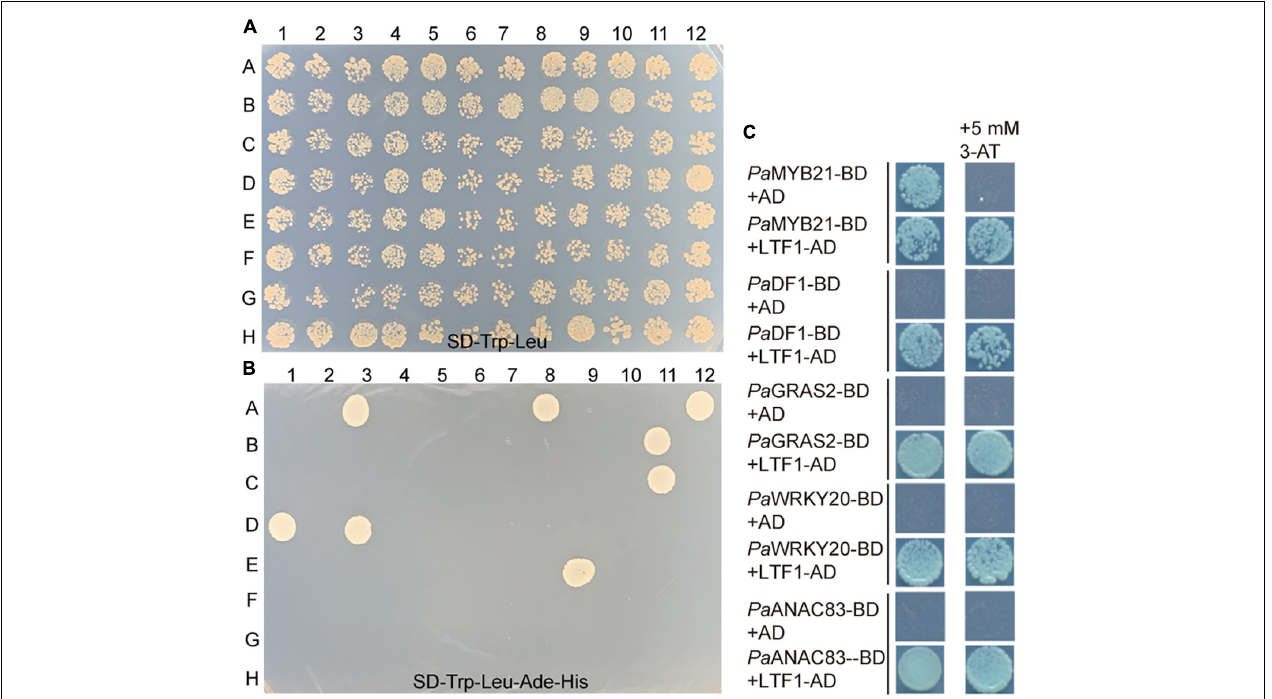
FIGURE 3 | Identification of TFs that interact with Pa MYB4/LTF1. (A,B) Y2H screening of this TFs library by mating the bait Pa MYB4/LTF1. Strong interaction can be detected on the stringent medium SD-Leu-Trp-His-Ade. (C) Y2H assays in yeast confirming the interaction between Pa MYB4/LTF1 and Pa MYB21, Pa DF1, Pa GRAS2, Pa WRKY20, or Pa ANAC83 in vivo . Plasmids transformed into AH109 were screened on the SD/-Trp-Leu-His-Ade medium with or without 5 mM 3-AT.